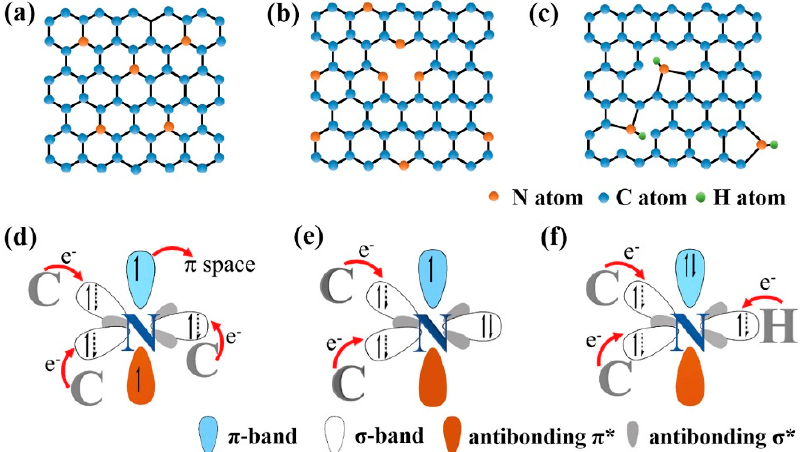
Figure 1. ( a – c ) Types of bonding between nitrogen and carbon configurations existing in the carbon materials: N–Q, N–6, and N–5. ( d – f ) A scheme of the doped atom electronic structure. Indication: * materials: N-Q, N-6, and N-5. ( d – f ) A scheme of the doped atom electronic structure. Indication: antibonding molecular orbital. Adapted from [19], with permission from Carbon, 2017. * antibonding molecular orbital. Adapted from [19], with permission from Carbon ,